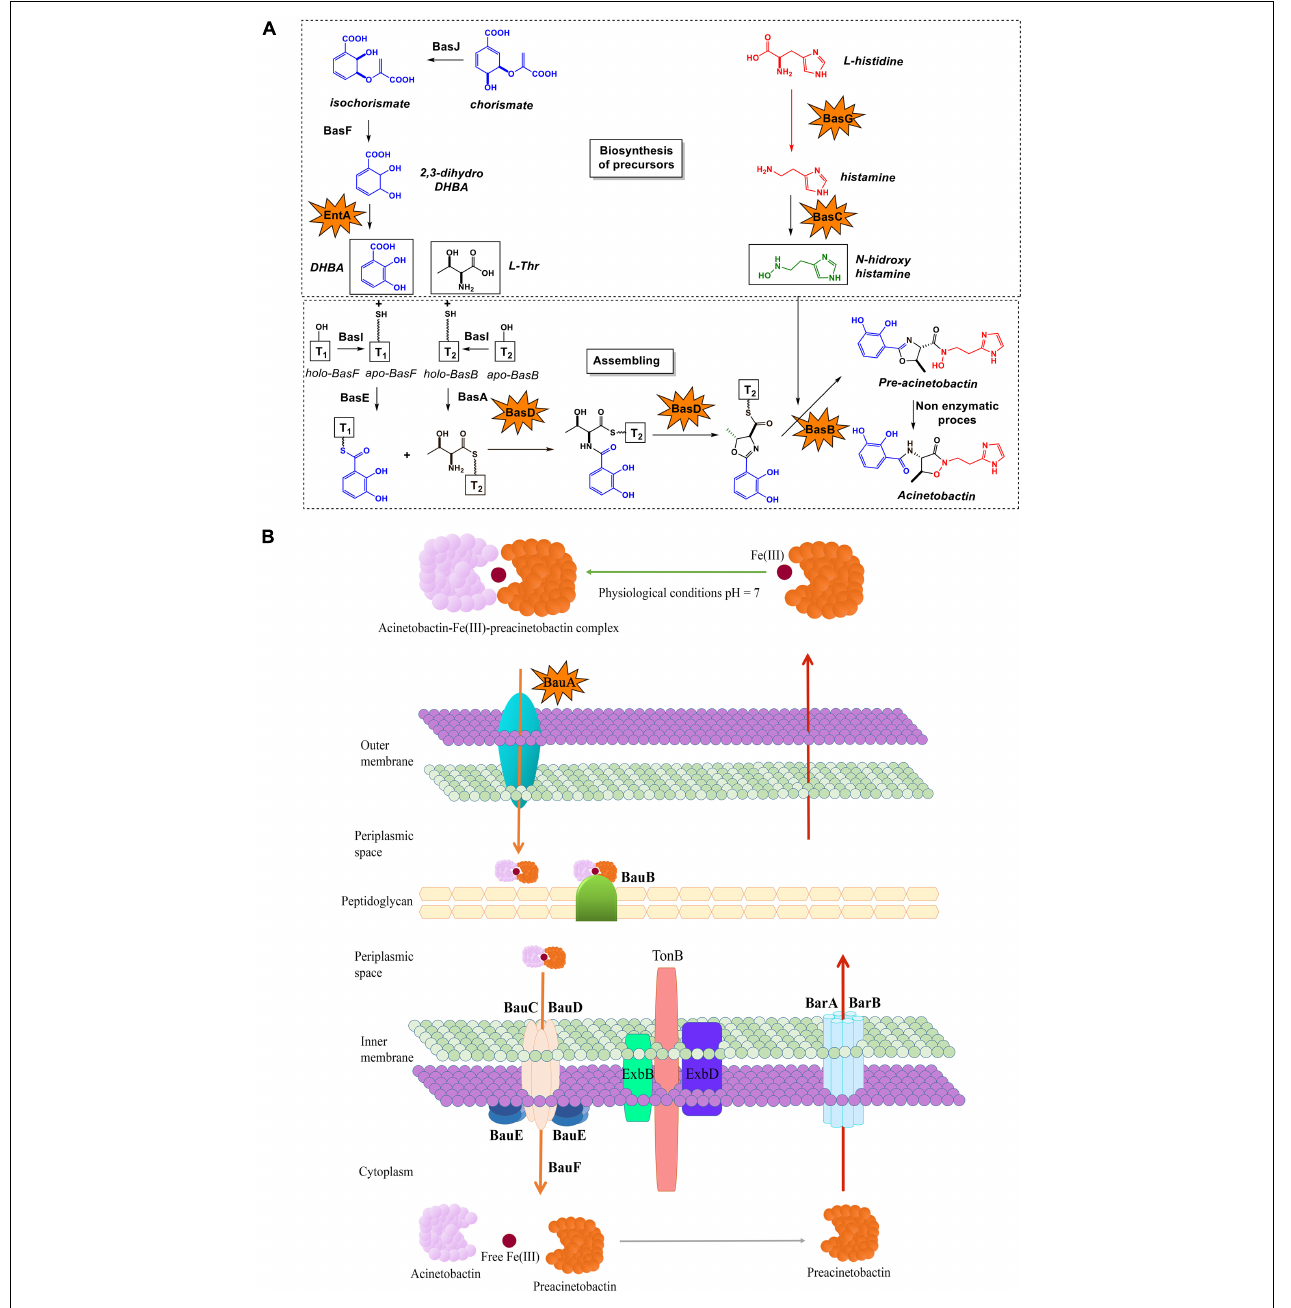
FIGURE 1 | Proposed (A) biosynthetic pathway and (B) transport mechanism of acinetobactin in A. baumannii . The six proteins found to be essential for the development of the bacteremia infection are marked with stars.